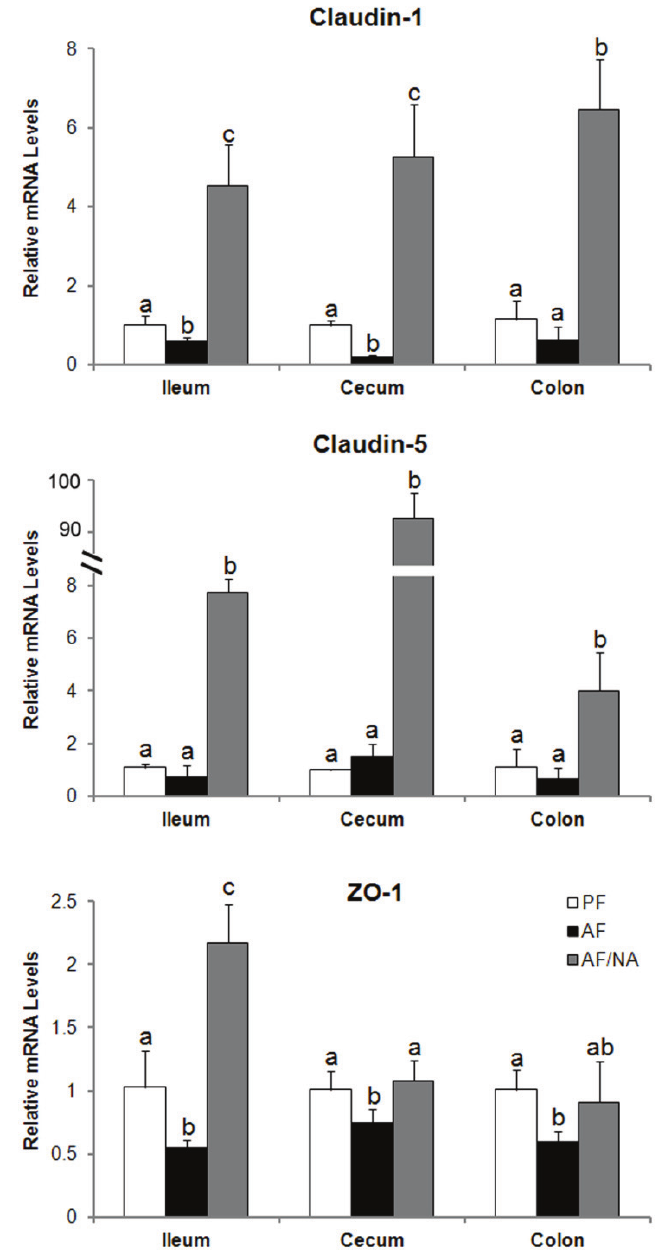
Figure 4. Expression of the intestinal tight junction proteins in rats fed alcohol with or without nicotinic acid supplementation for 8 weeks. Gene expression was assessed by qPCR assay of the mRNA level. Results are means ± SD ( n = 6–8). Significant differences ( p < 0.05, ANOVA) are identified by different letters. PF: pair-fed; AF: alcohol-fed; AF/NA: alcohol-fed with nicotinic acid